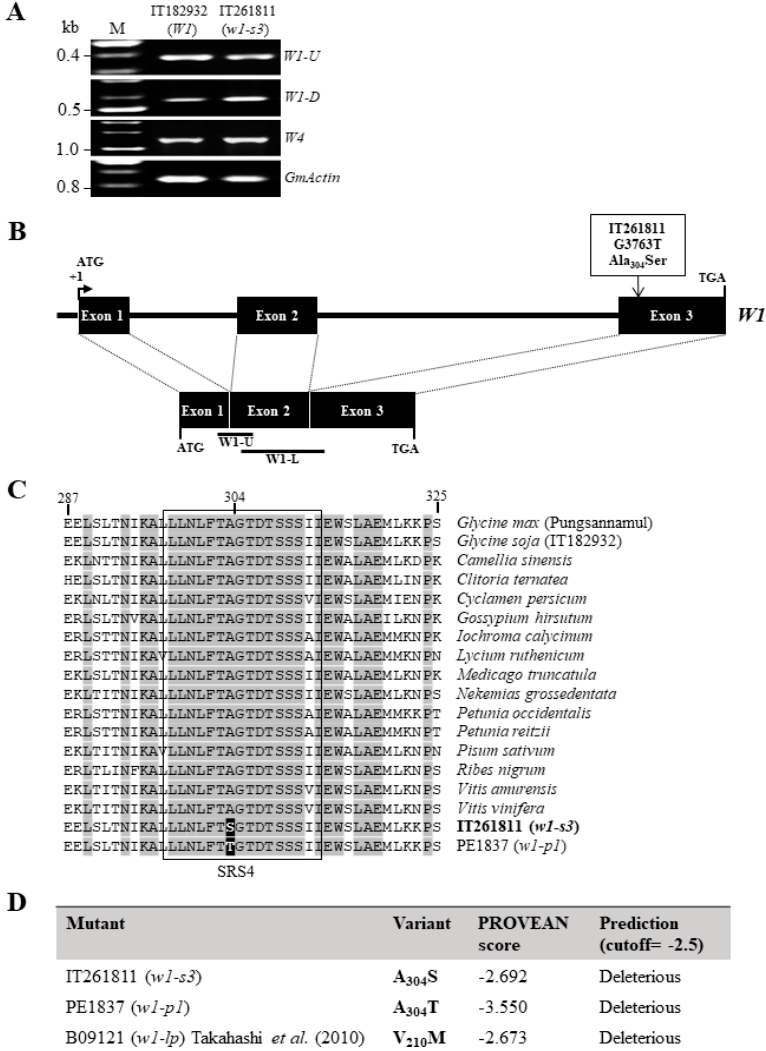
Figure 2. Expression profiles of W1 and W4 genes and schematic representation of the F3 (cid:48) 5 (cid:48) H allele along with F3 (cid:48) 5 (cid:48) H protein variation analysis. ( A ) Gene expression analysis of W1 and W4 through RT-PCR was performed in the purple-flowered line (IT182932) and the pinkish-white-flowered mutant line (IT261811). The 5 (cid:48) and 3 (cid:48) half regions of F3 (cid:48) 5 (cid:48) H are designated as W1-U and W1-L , respectively. GmActin , a housekeeping gene, was used as the loading control. M, a 1-kb molecular marker. ( B ) Gene structure of W1 and polymorphism between W1 and w1-s3 alleles. White boxes indicate mutational change in the recessive w1-s3 allele at the W1 locus. Black boxes indicate exons. W1-U and W1-L denote the 5 (cid:48) and 3 (cid:48) parts of W1 , respectively. ( C ) Amino acid alignments of F3 (cid:48) 5 (cid:48) H proteins. The amino acid sequences of 14 F3 (cid:48) 5 (cid:48) H proteins from different plant species were compared with wild-type F3 (cid:48) 5 (cid:48) H and mutant proteins. Gray text indicates identical amino acids. White letters with a black highlight indicate relevant amino acid substitutions. Thick black box indicates the SRS4 domain. GenBank accession numbers of F3 (cid:48) 5 (cid:48) H proteins are as follows: Camellia sinensis , AAY23287; Clitoria ternatea , BAF49293; Cyclamen persicum , ACX37698; Gossypium hirsutum , ACH56524; Iochroma calycinum , AIY22750; Lycium ruthenicum , AGT57963; Medicago truncatula , XP_013459330; Nekemias grossedentata , AGO02173; Petunia occidentalis , BAF34571; Petunia reitzii , BAF34572; Pisum sativum , ADW66160; Ribes nigrum , AGI16385; Vitis amurensis , ACN38269; and Vitis vinifera , BAE47007. ( D ) PROVEAN scores of amino acid variations identified in w1-s3 , w1-p1 , and w1-lp mutants. The PROVEAN tool sets the threshold at − 2.5 as